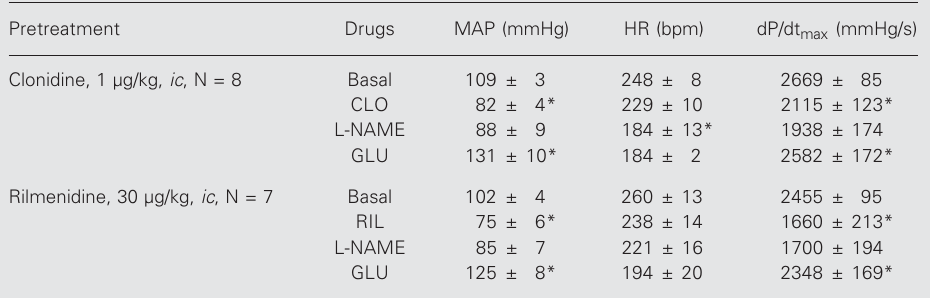
Table 2. Hemodynamic effects of intracisternal ( ic ) administration of clonidine (CLO) and rilmenidine (RIL) before injection of N (cid:2) -nitro-L-arginine methyl ester (L-NAME, 40 mg/kg, iv ) and L-glutamate (GLU, 10 µmol, icv ) in pentobarbital-anesthetized rabbits.